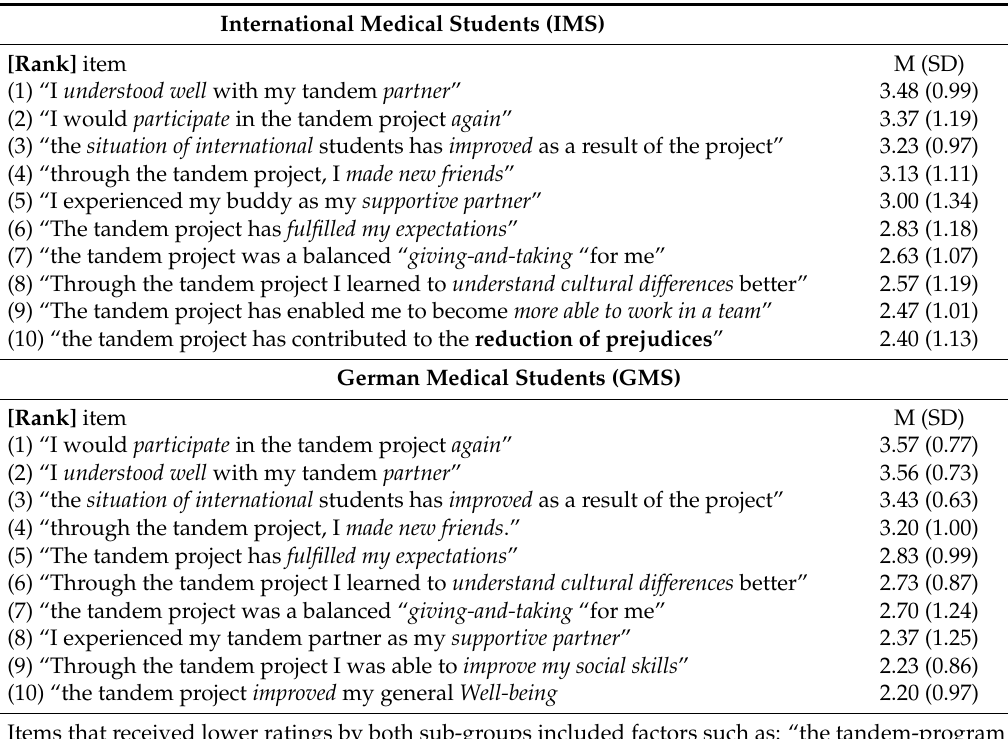
Table 4. Most important experiences and views of IMS and GMS regarding participation in the